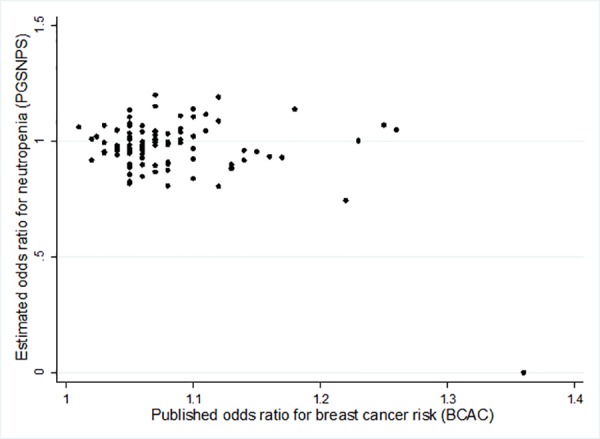
Scatter plot comparing variant-associated odds ratios for breast cancer risk, published by the Breast Cancer Association Consortium (BCAC), with odds ratios for neutropenia risk estimated in the Pharmacogenetic SNPs (PGSNPS) study.